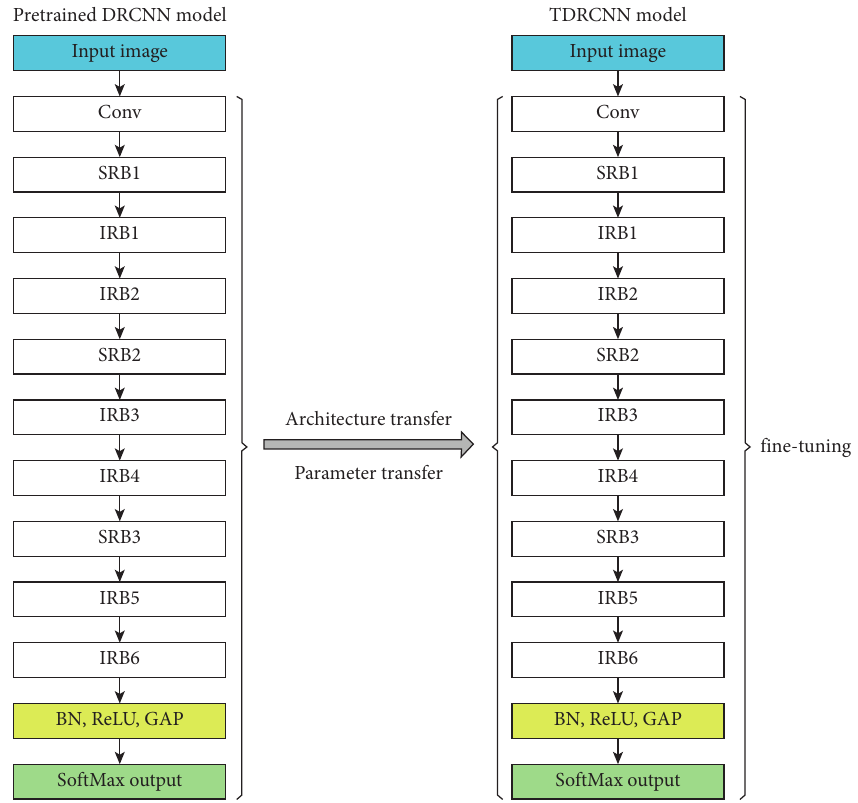
Figure 4: The transfer learning strategy of building the